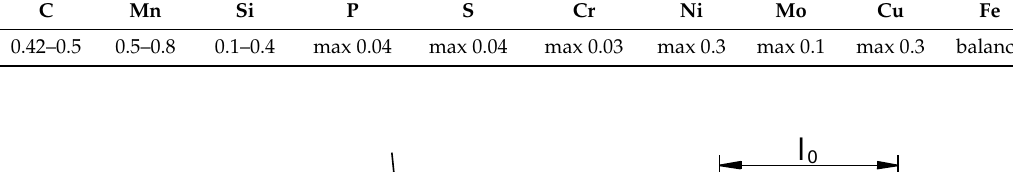
Figure 2. The working zone of a cross-rolling mill adapted to conduct the rotational compression of cylindrical samples. The samples were manufactured from a drawn bar with a Ø 30 mm diameter, divided into pieces with the length equal 30 mm, 60 mm, 90 mm, 120 mm and 150 mm. Before forming, the samples were heated to the temperature T = 1150 °C in an electrical chamber furnace. An initial series of tests showed that the rotational compression process will be performed at the reduction ratio δ = 1.15, which was compliant with the distance between the working surfaces of tools 2 h = 26.1 mm. It was the smallest possible distance at which the rotating motion occurred during the compression. It was also established that the length of the s path ought to be equal 315 mm. On this path, the compressed sample (Figure 3) rotated 3 ÷ 3.5 times and its front surfaces showed no signs of cracking.